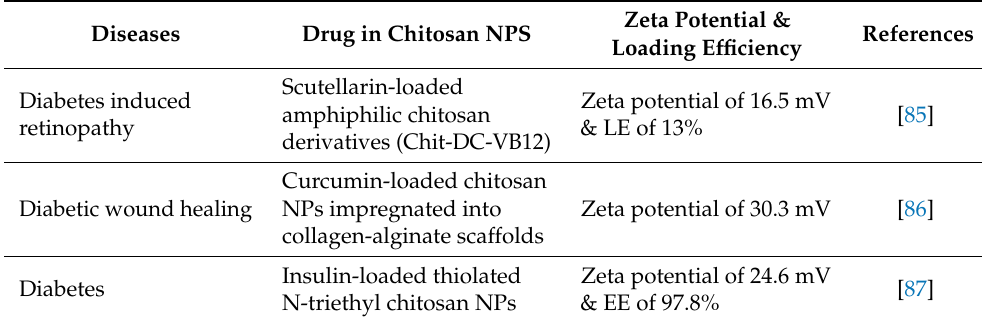
Table 5. Chitosan NPS in diabetes and diabetes induced